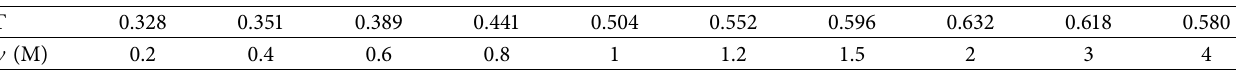
Figure 1: Drag coefficient as a function of Mach number for a sphere, the solid lines are data from two experiments designed to find the drag coefficient of smooth spheres at different Mach numbers [23, 24], the dotted blue line is the best fit function, and the line of circles is Modified Newtonian Theory [25]. Table 1: The drag coefficient Γ depending on the body speed in Mach (M) units for symmetrical shape of the body without rotation, rewritten to the table form